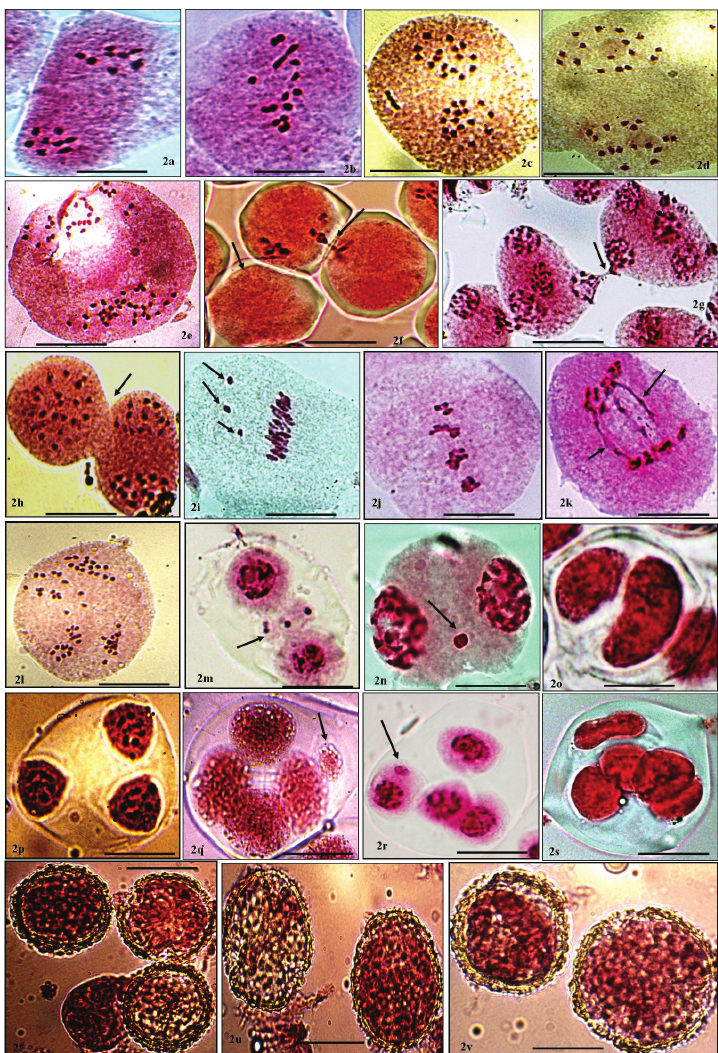
Figure 2. a (Diploid cytotype) PMC at Anaphase-I showing 8:8 distribution of chromosomes b (Dip- loid cytotype) PMC at Metaphase-I showing 8II bivalents c (Tetraploid cytotype) PMC at Anaphase-I showing 16:16 distribution of chromosomes d PMC at Metaphase-II showing 16:16 distribution of chromosome e (Octaploid cytotype) PMC at Anaphase-I showing 32:32 distribution of chromosomes f (Diploid cytotype) Three PMCs showing transfer of chromatin material (arrowed) g A group of PMCs (arrowed) involved in cytomixis at telophase-I h (Tetraploid cytotype) Size difference and direct connec- tion between two PMCs during chromatin material (arrowed) i PMC at metaphase-I showing unoriented bivalent (arrowed) j PMC at metaphase-I showing chromatin stickiness k PMC at anaphase-I showing chromatin bridges (arrowed) l PMC at anaphase-II showing unequal distribution of chromosomes (ar- rowed) m–n PMC at telophase-I showing chromatin chromosomal laggards (arrowed) o Diad p Triad q–r Tetrad with micronuclei (arrowed) s Polyad t–v Fertile, sterile and Heterogeneous sized fertile pollen grains. Bar = 10